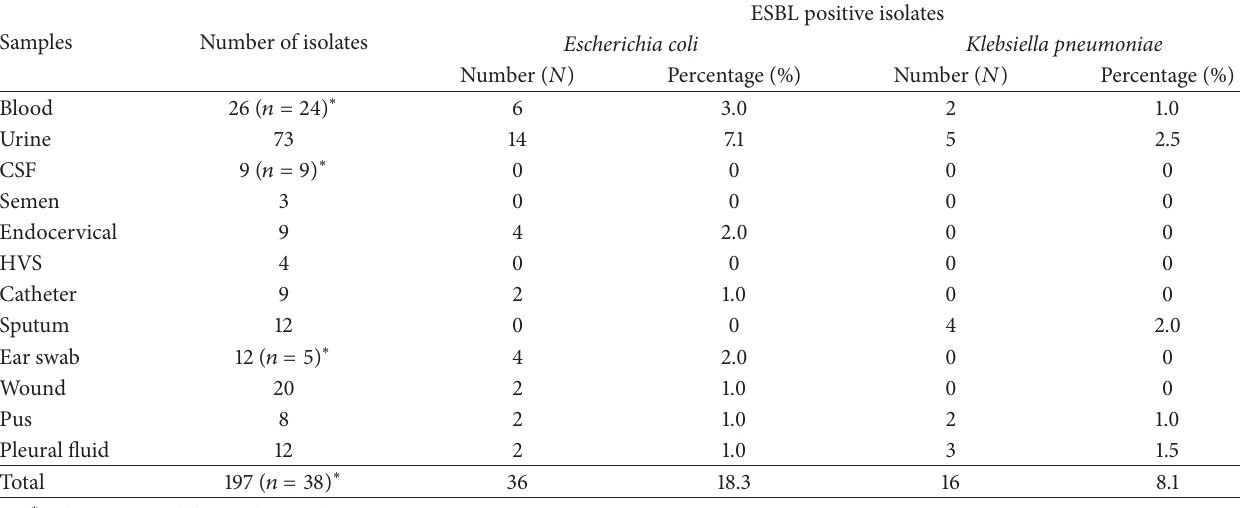
Table 2: Frequency rate of ESBL positive E. coli and Klebsiella pneumoniae in various clinical samples. Samples